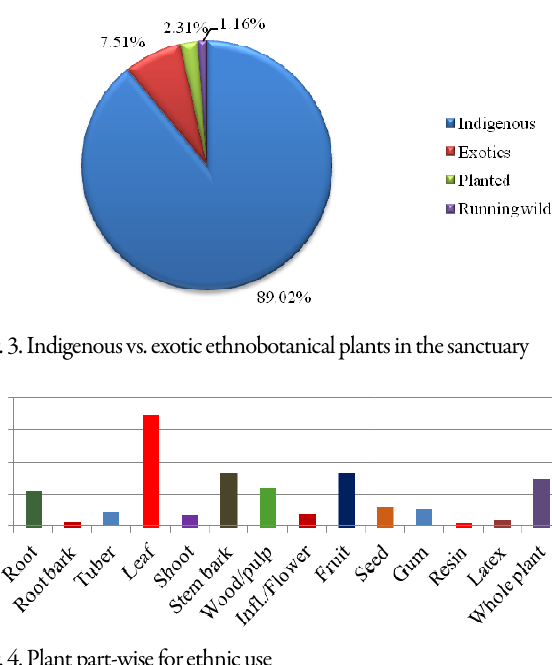
Fig. 4. Plant part-wise for ethnic use